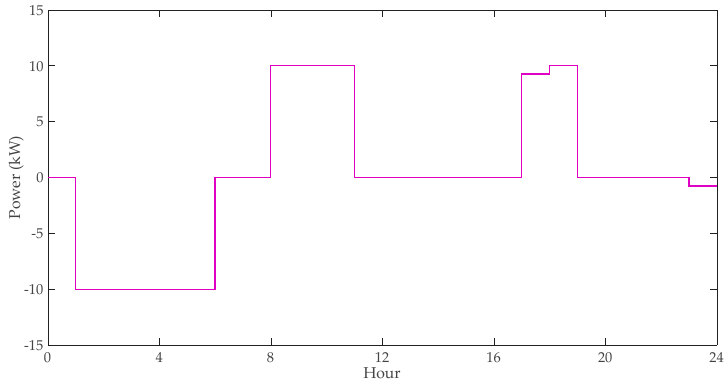
Figure 7. Active power of the EESS connected at the bus #6 (case study 1).